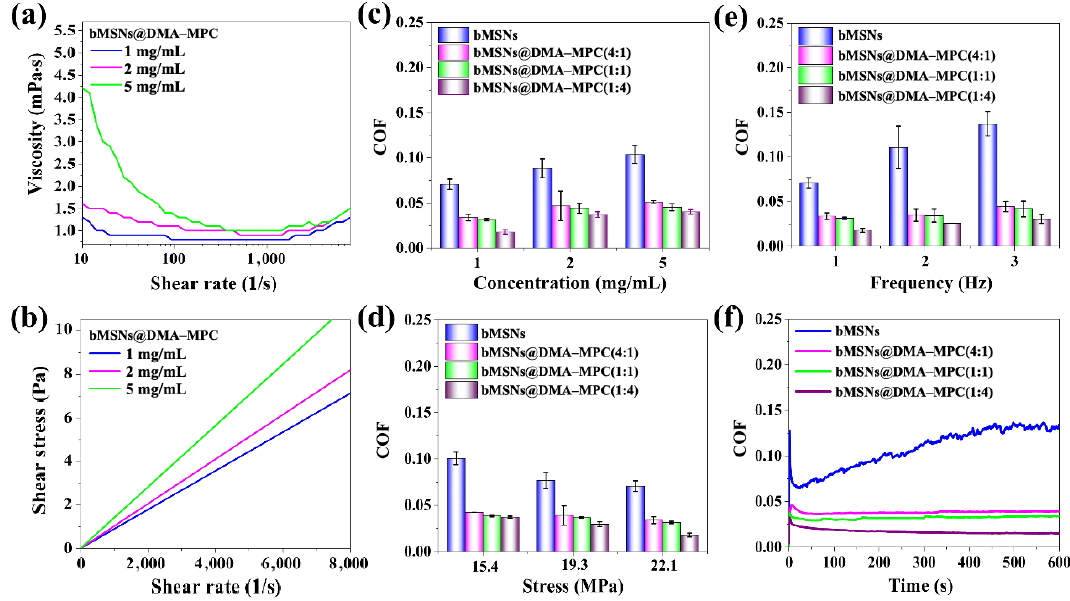
Fig. 5 Characterizations of the rheological properties and lubrication performances of the bMSNs and bMSNs@DMA–MPC nanoparticles under various experimental conditions: (a) viscosity vs. shear rate curve and (b) shear stress vs. shear rate curve for bMSNs@DMA– MPC (1:4) at the concentrations of 1, 2, and 5 mg/mL. COF values of bMSNs and bMSNs@DMA–MPC at different conditions: (c) concentration: 1, 2, and 5 mg/mL; contact stress: 22.1 MPa; and reciprocating frequency: 1 Hz; (d) contact stress: 15.4, 19.3, and 22.1 MPa; concentration: 1 mg/mL; and reciprocating frequency: 1 Hz; and (e) reciprocating frequency: 1, 2, and 3 Hz; concentration: 1 mg/mL; and contact stress: 22.1 MPa. (f) COF–time curves of bMSNs and bMSNs@DMA–MPC at a concentration of 1 mg/mL, a contact stress of 22.1 MPa, and a reciprocating frequency of 1